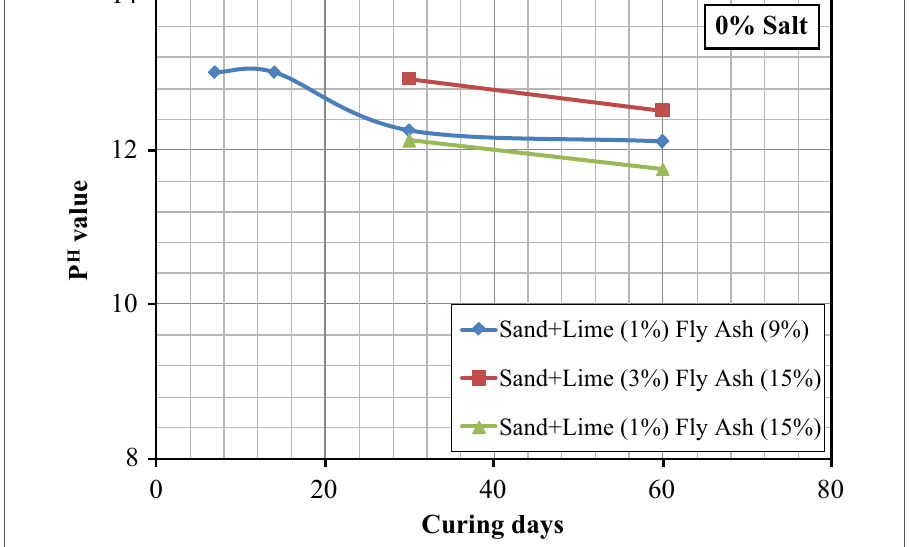
Fig. 8 pH value verses curing days